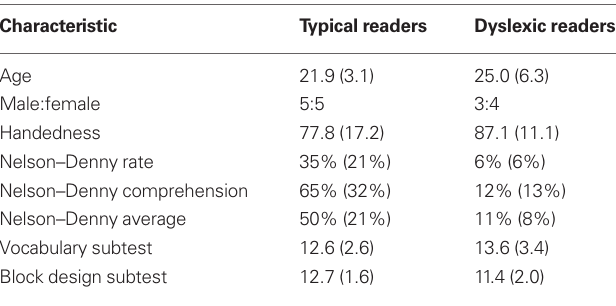
Table 1 | Participant characteristics [mean (standard